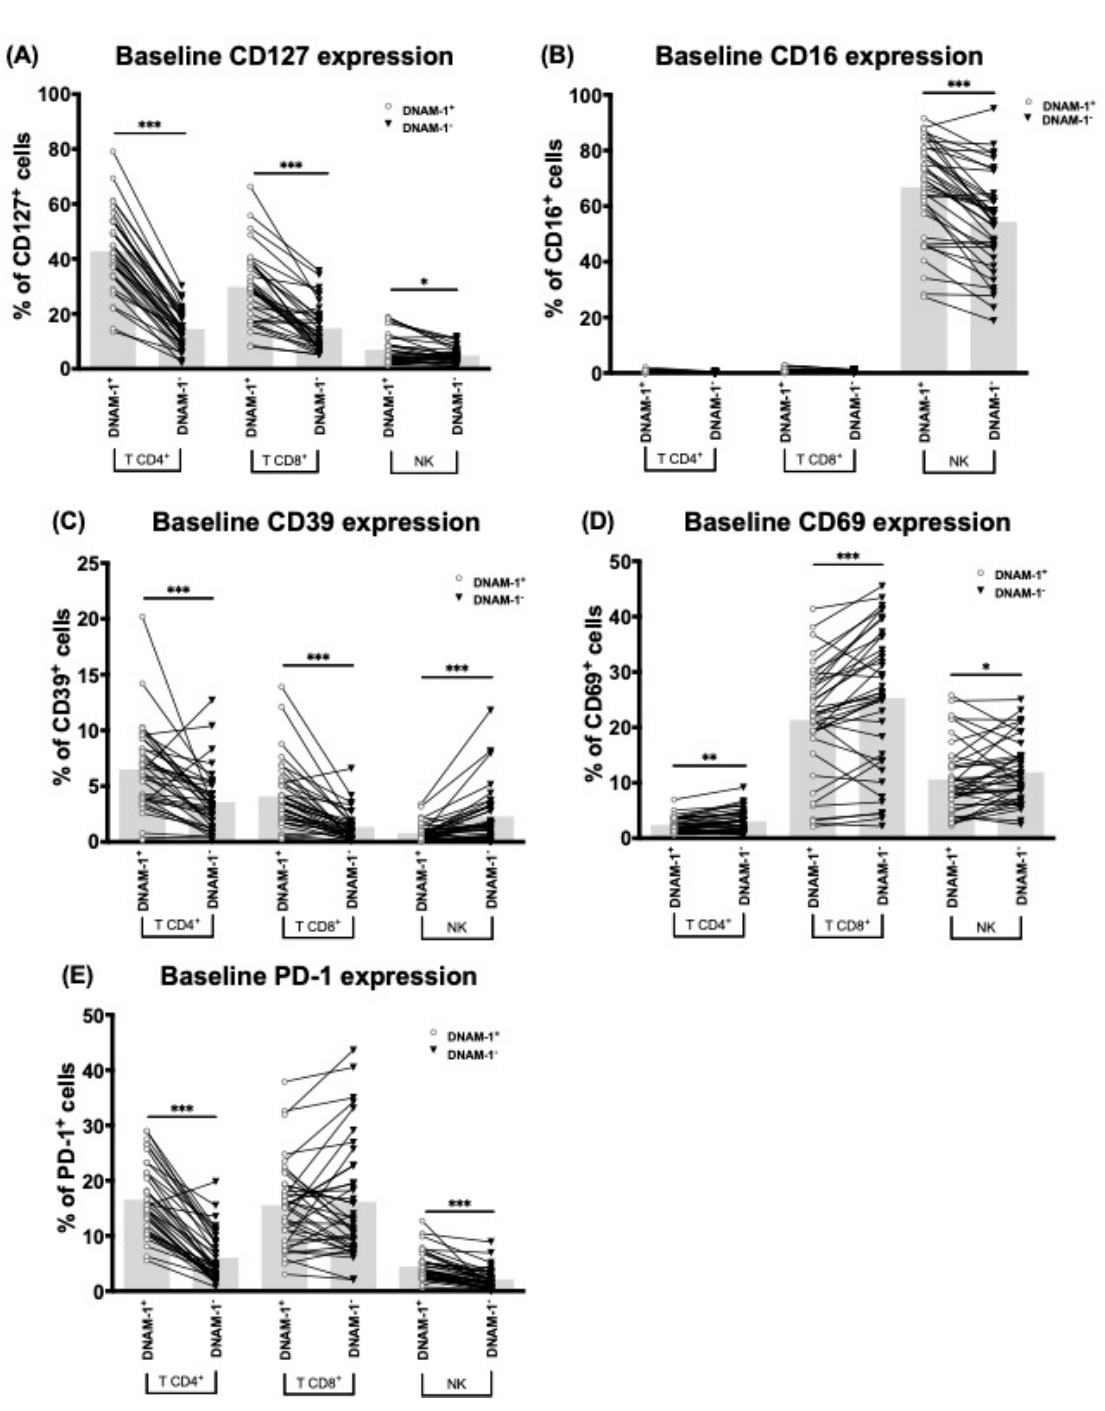
Figure 3. DNAM-1 + cells characterization. Comparison between CD127 ( A ), CD16 ( B ), CD39 ( C ), CD69 ( D ), and PD-1 ( E ) expressing cells in DNAM-1 + and DNAM-1 − subgroups of T CD4 + , T CD8 + , and NK cells of sorafenib treated patients at baseline ( n = 52). Bar height represents the mean of each group. *: p < 0.05, **: p < 0.01, ***: p < 0.005. CD127, LAG-3, CD39, CD69, PD-1 and NKG2D MFI quantification allowed us to confirm the results and define additional differences for LAG-3 and NKG2D expression (Figure 4). For T cells, both LAG-3 and NKG2D had higher MFI in the DNAM-1 +